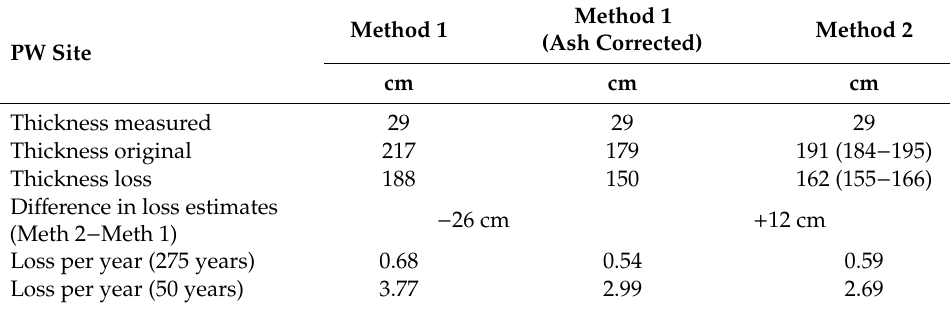
Table 5. Losses of thickness at